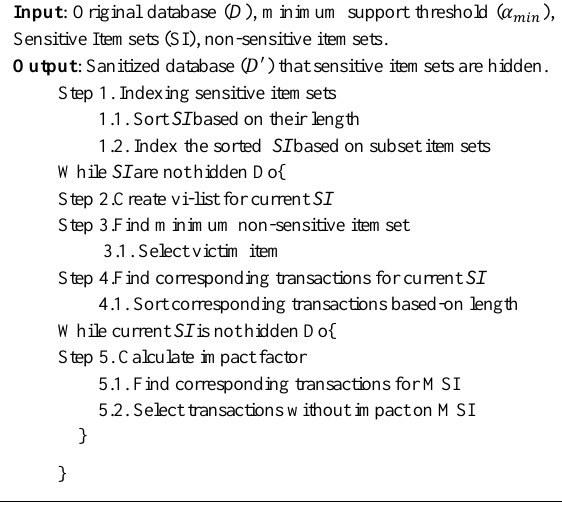
Figure 2. The pseudo-code of the HIF.